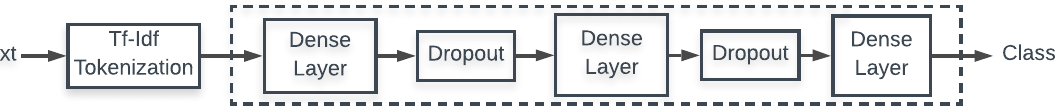
Figure 2. A Recurrent CNN with pre-trained Embeddings.